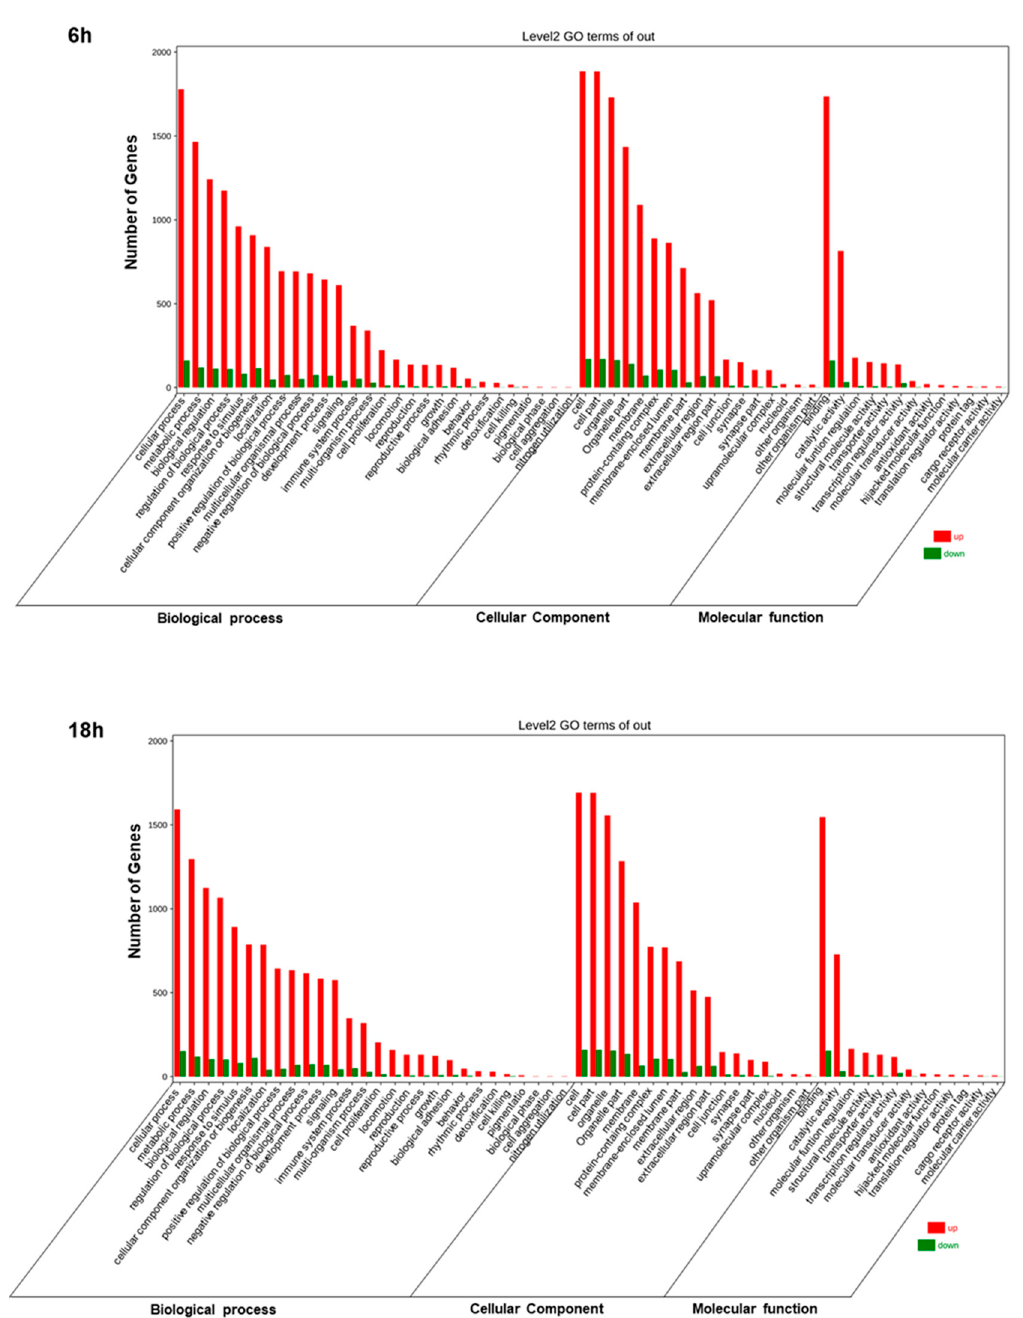
Figure 7. GO analysis. GO annotation for 6 h and 18 h of treatments of DEGs. The number of enriched genes is presented.